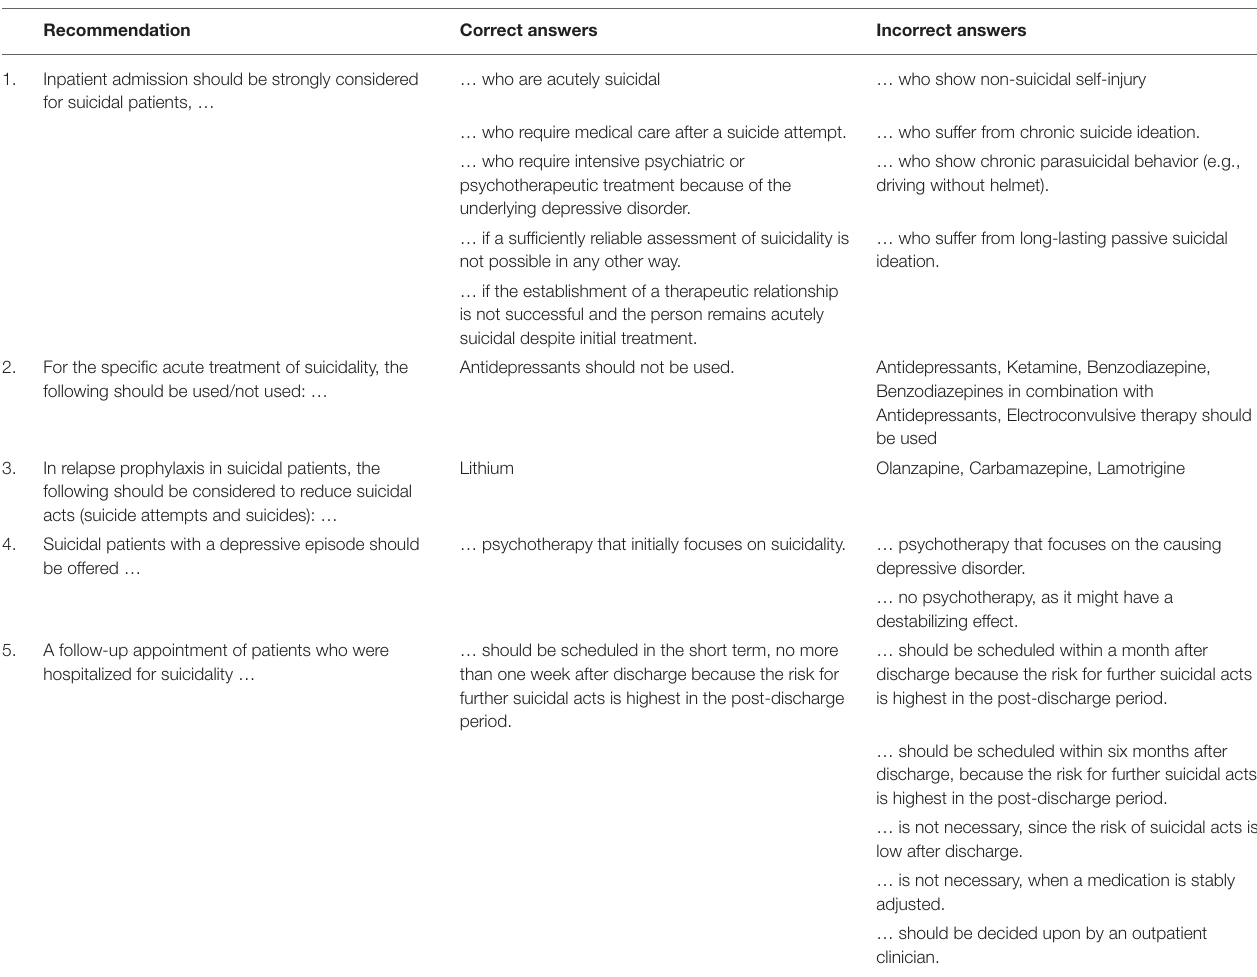
TABLE 1 | Overview of guideline recommendations and distractor